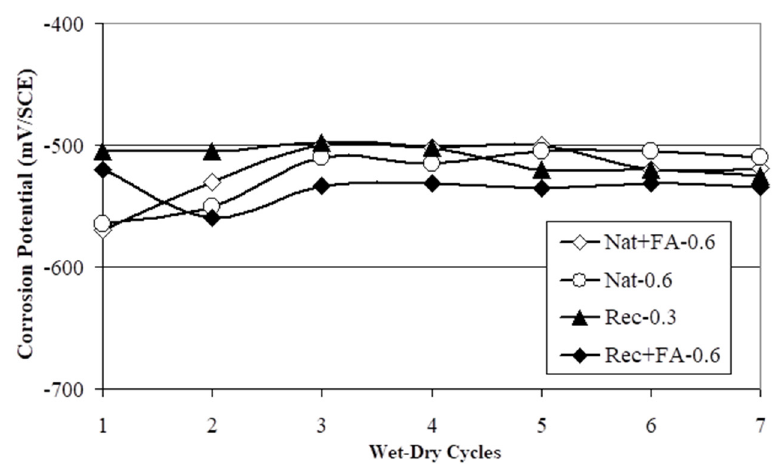
Figure 5. Corrosion potential of bare steel plates in cracked concrete as a function of wet–dry cycles.